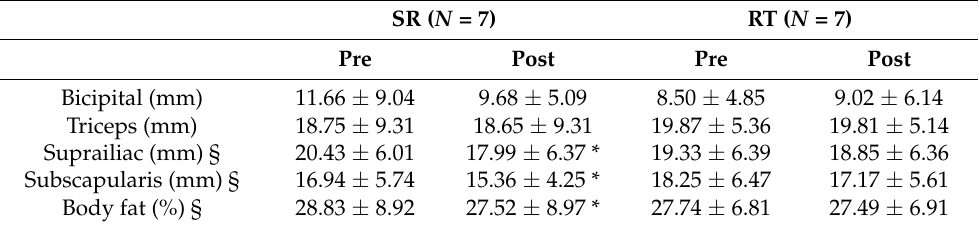
Table 3. Skinfold results of spot reduction (SR) and resistance training (RT) groups.